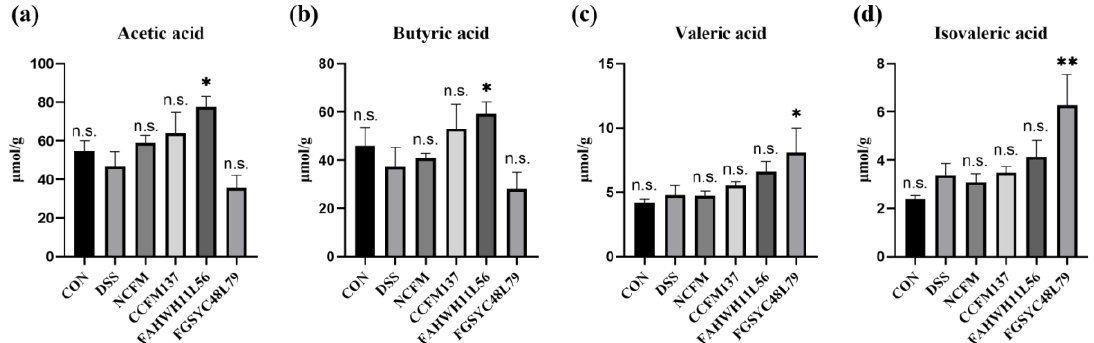
Figure 8. Effects of L. acidophilus on the content of short-chain fatty acids. ( a ) Acetic acid, ( b ) butyric acid, ( c ) valeric acid, ( d ) isovaleric acid. *: p < 0.05. **: p < 0.01. N.s.: no significant difference. All data are presented as mean ± standard error of the mean (SEM). The DSS group was used as a reference.